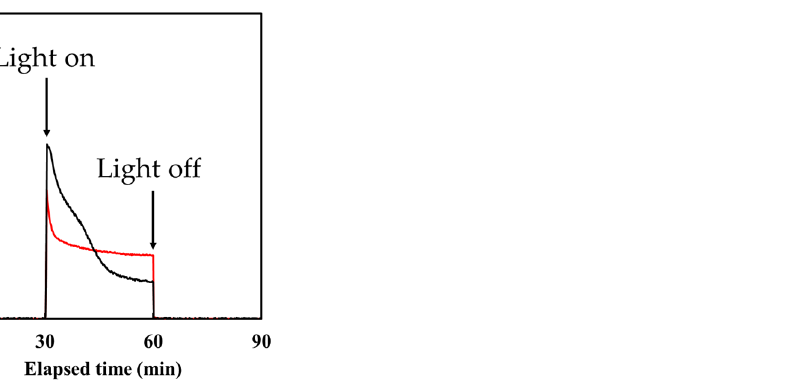
Figure 7. Results of the photocurrent density measurements under dark and UV irradiation of F Titania and F COMP .